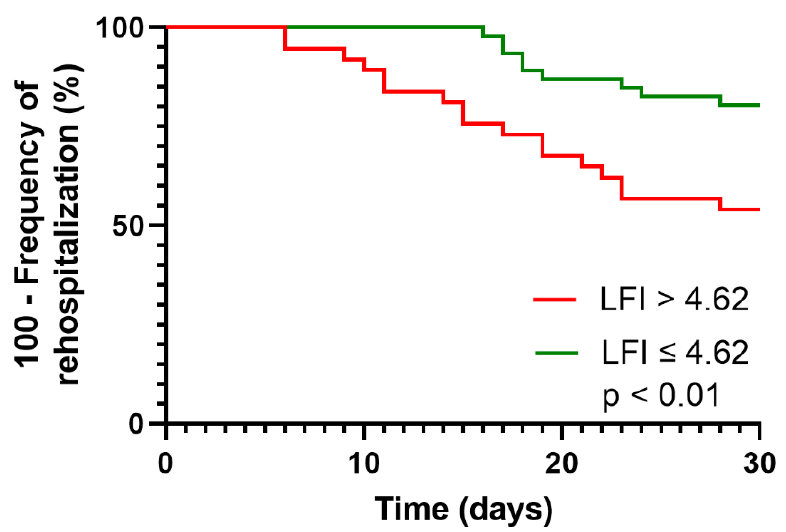
Figure 5. Kaplan–Meier curve displaying the time to rehospitalization in the total cohort stratified by an LFI cut-off of 4.62. Table 3. Discriminative ability of the liver frailty index (LFI) and its subtest for prediction a rehospi- talization within 30 days.